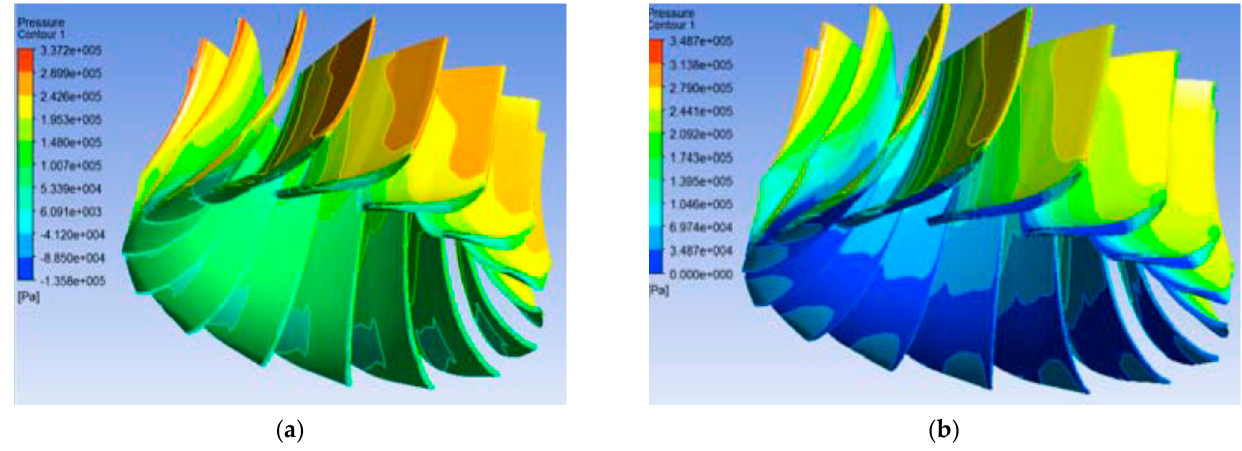
Figure 13. Pressure variation on runner ( a ) for rated load, ( b ) for overload condition [35].